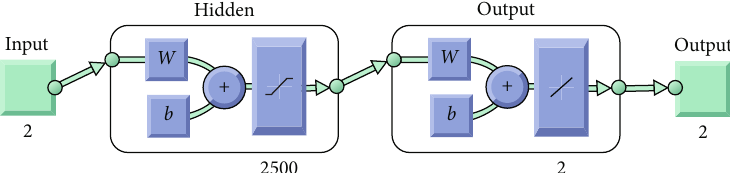
Figure 24: DNN model for the current regulator of a smart